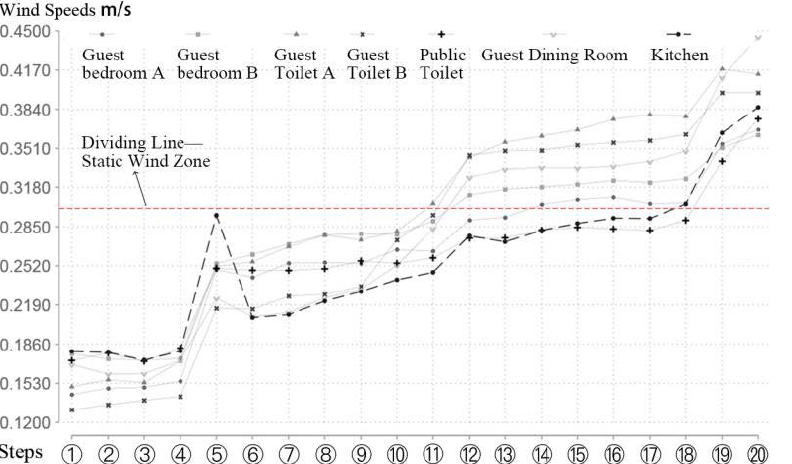
Figure 17. Comparison of average wind speed in the first-floor functional area at different optimization stages.